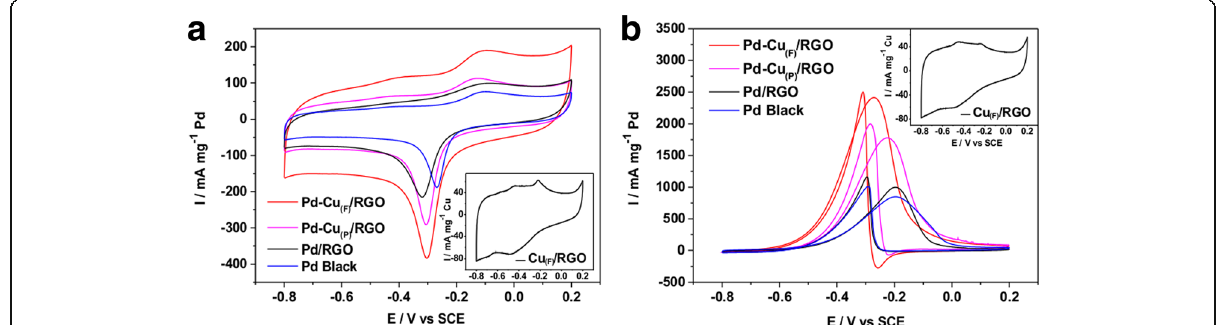
Fig. 7 Cyclic voltammograms of the Pd-Cu (F) /RGO, Pd-Cu (P) /RGO, Pd/RGO, and Pd black. CV plots in 0.5 M NaOH ( a ) and 0.5 M NaOH + 0.5 M C 2 H 5 OH ( b ) at a scan rate of 50 mV s − 1 . The inserted images are the cyclic voltammogram plots of Cu (F) /RGO in 0.5 M NaOH ( a ) and 0.5 M NaOH + 0.5 M C